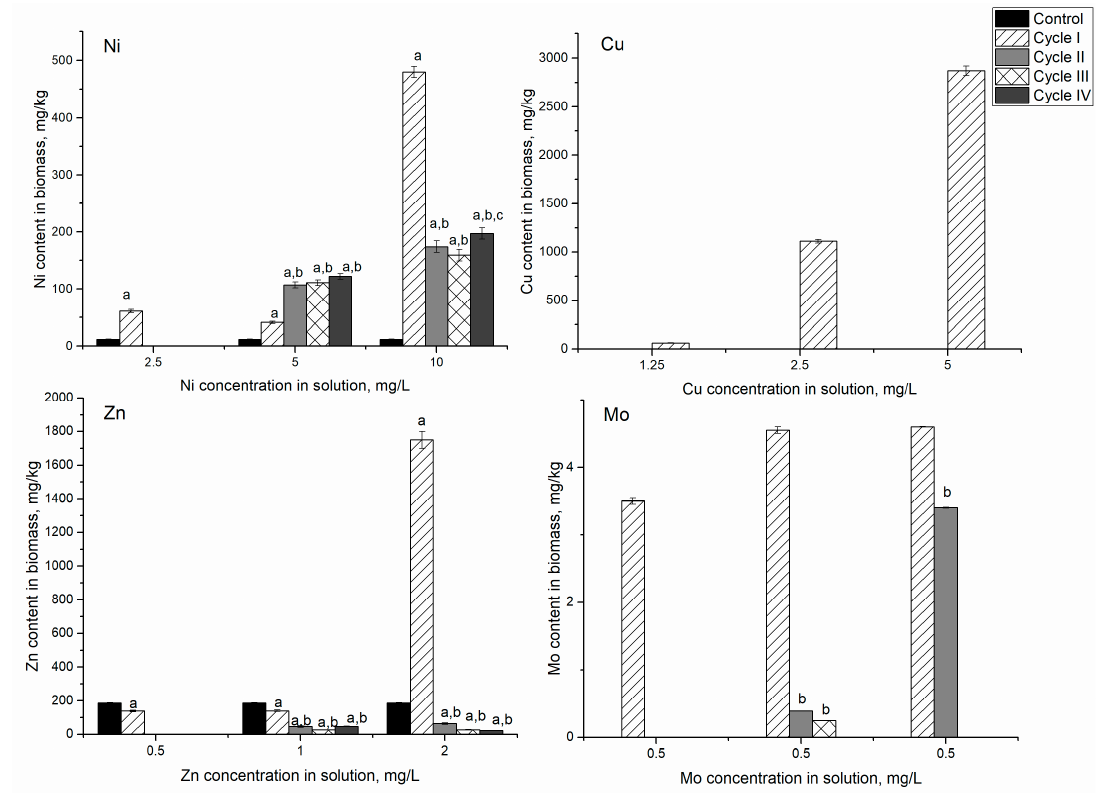
Figure 10. Accumulation of metal ions in spirulina biomass during repeated cultivation in the medium containing metal ions at concentrations: nickel 2.5–10 mg/L, copper 1–5 mg/L, zinc 0.5–2 mg/L, and molybdenum 0.5 mg/L. a: p < 0.001 for the difference between experimental and control samples; b: p < 0.001 for the difference from the first cycle; c: p < 0.001 for the difference from the second cycle.